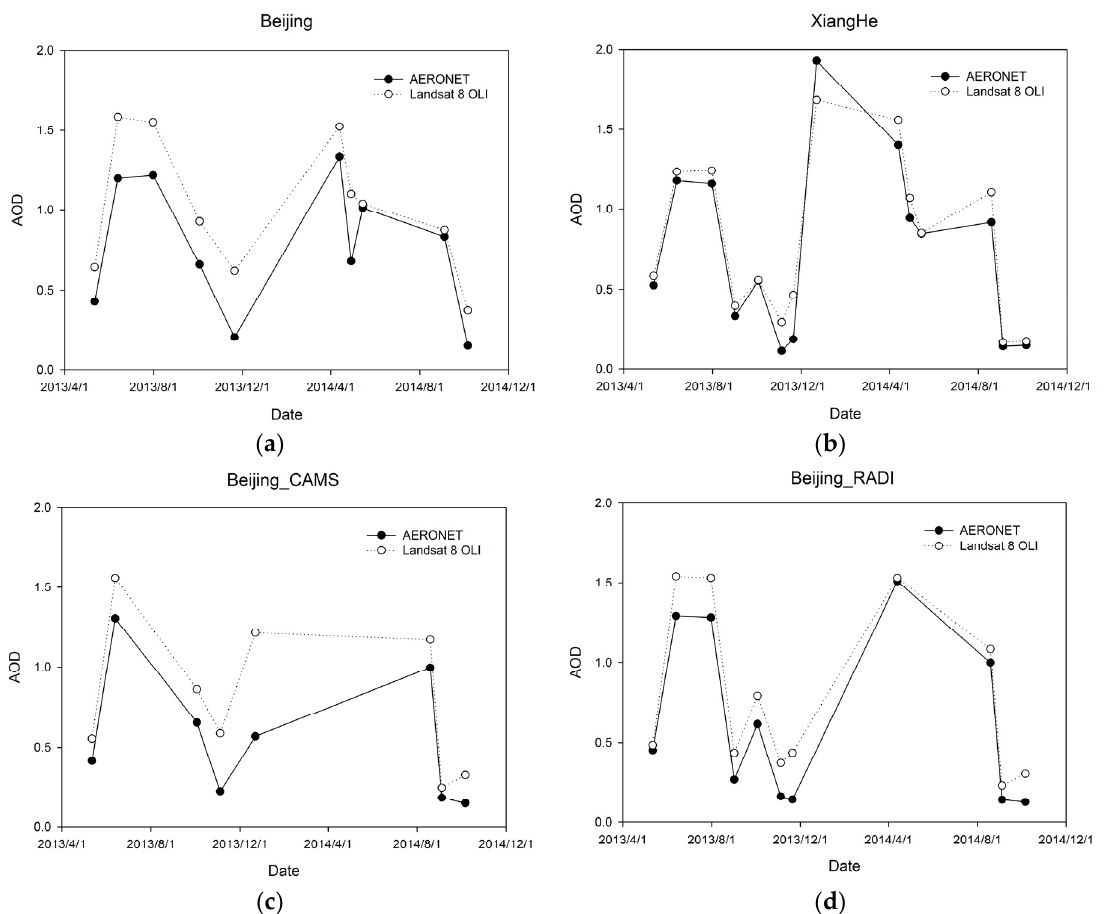
Figure 7. Comparison between AOD retrieved with the proposed algorithm and AOD measured by AERONET stations at 550 nm: ( a ) Beijing site; ( b ) Xianghe site; ( c ) Beijing_CAMS site and ( d ) Beijing_RADI site.